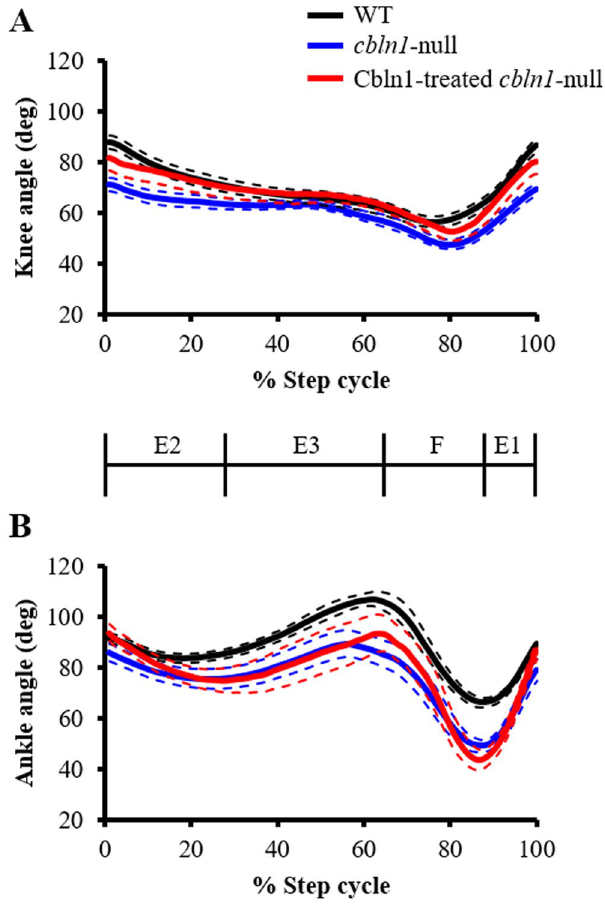
Figure 6. Joint angle displacement after injection of Cbln1. Average angular displacements after injection of Cbln1 into cbln1 -null mice (Cbln1-treated cbln1 -null, red line) during step cycles. ( A ) knee, ( B )